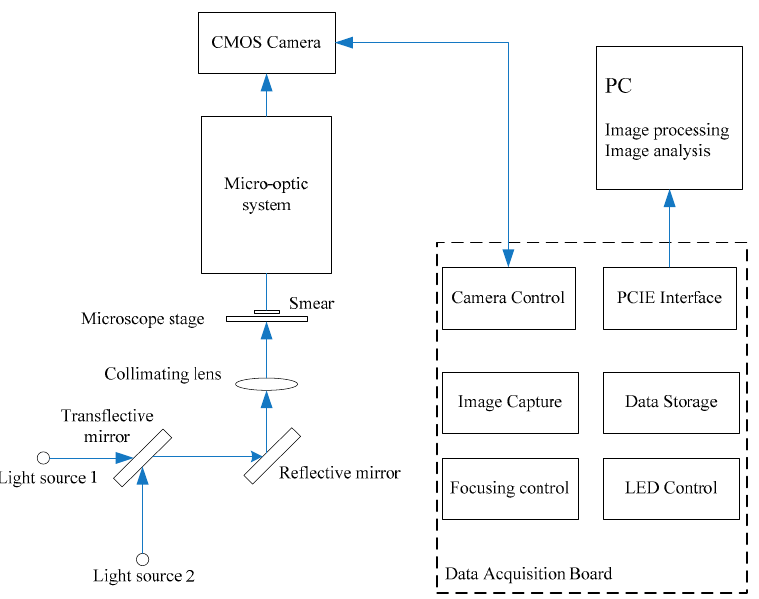
Figure 1. Schematic diagram of microscopic multi-spectral imaging system.